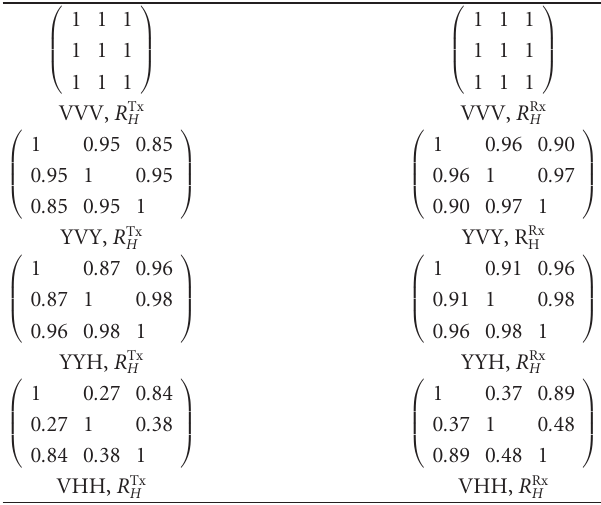
Table 2: Correlation matrix for di ff erent polarization schemes in LOS environment. ⎛